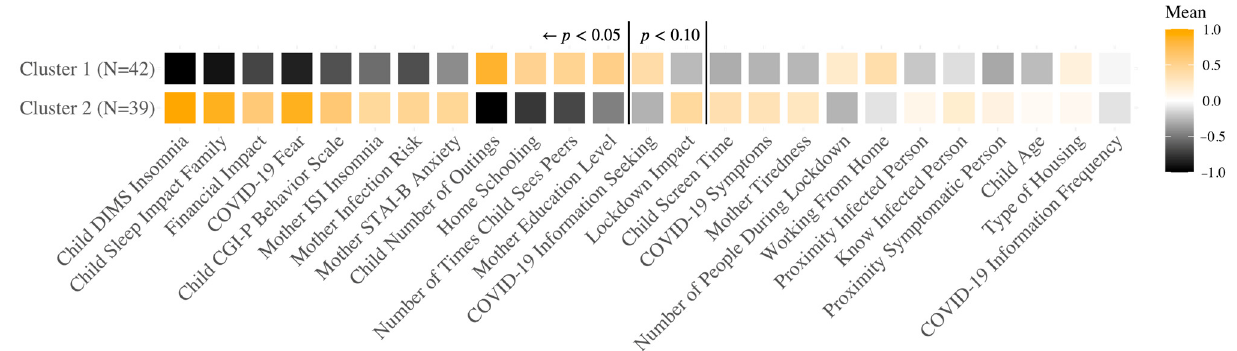
Figure 1. Hierarchical clustering analysis results for the French sample. Each square represents the average value of the corresponding variable (transformed Yeo-Johnson) [70]. Brighter colors indicate high values while blacker colors indicate low values. The variables are ordered based on the most significantly different, positively, between the clusters, then negatively, then the non-significant differences. Variables to the left of the first vertical line are significantly different between the clusters. DIMS: Difficulties Initiating and Maintaining Sleep; CGI-P: Conners’ Global Index; ISI: Insomnia Severity Index; STAI-B: State Trait Anxiety Inventory form Y-B.